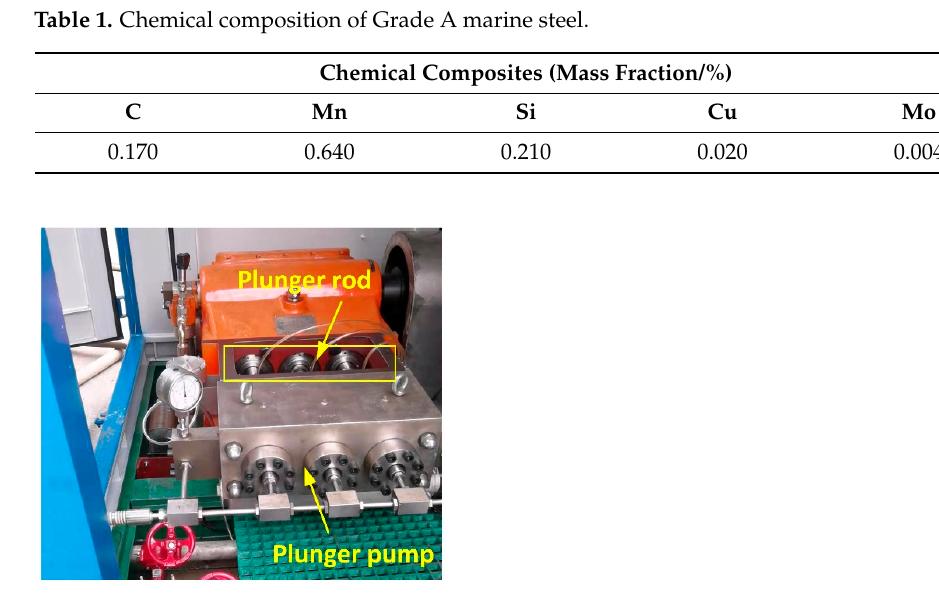
Figure 3. Ultrahigh ‐ pressure water jet test platform. Figure 3. Ultrahigh-pressure water jet test